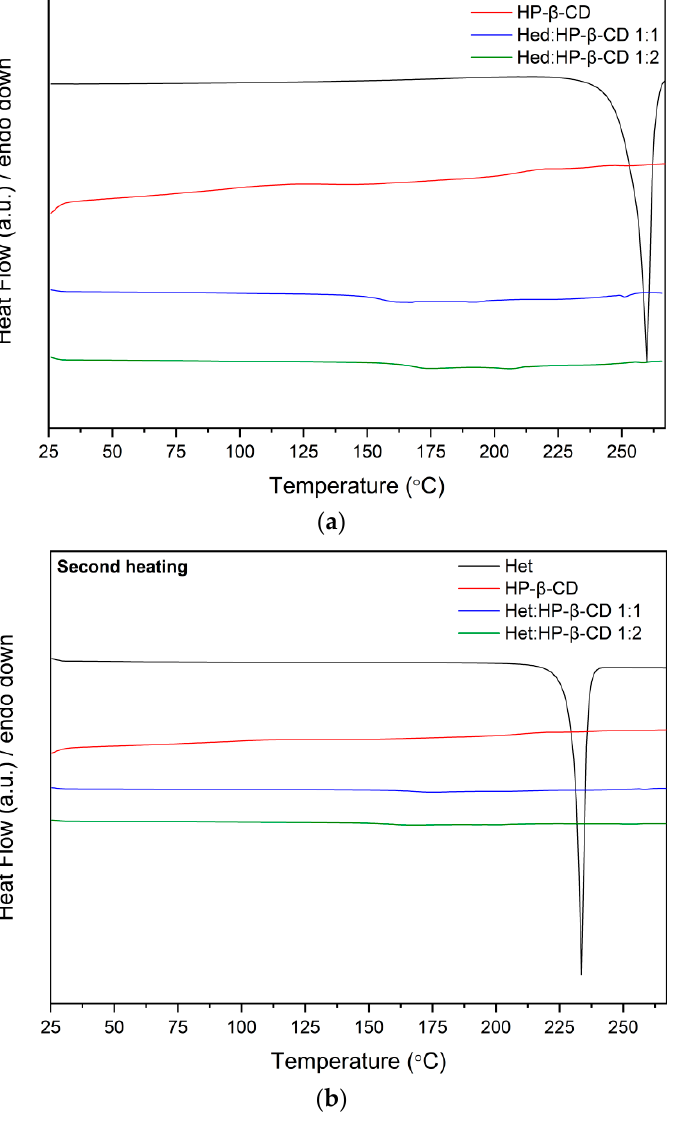
Figure 4. The results of DSC analysis from the second heating scan of Hed ( a ) and Het ( b ) systems.